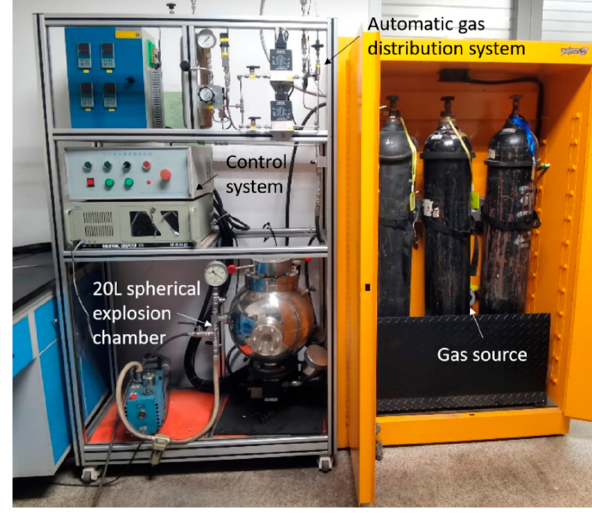
Figure 2. The 20 L spherical explosive device.